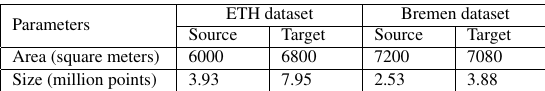
Table 1. Information of experimental datasets